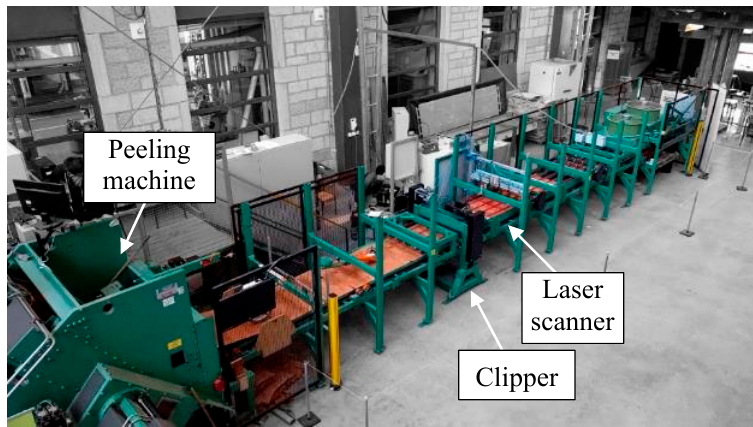
Figure 1. Experimental peeling line from LaBoMaP.